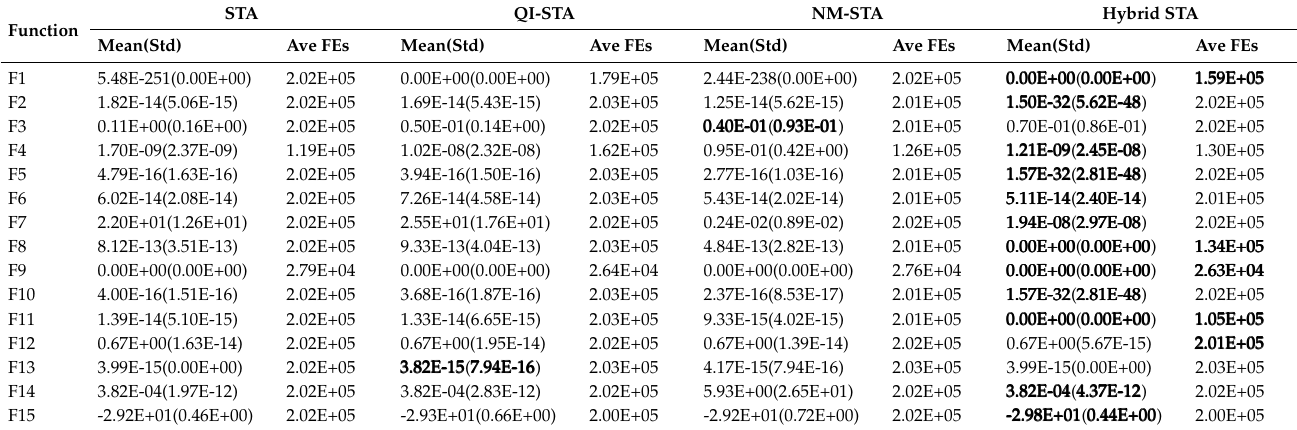
Table 7. Statistical results for the STA family with D =